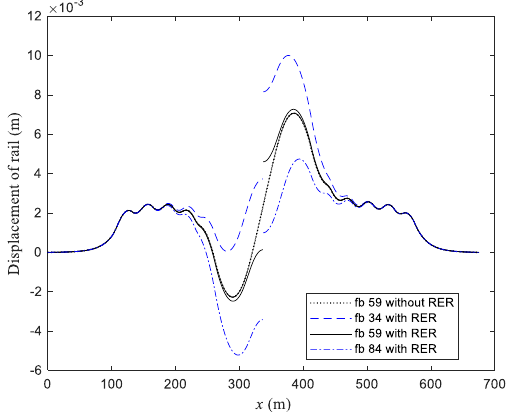
Figure 12. Longitudinal displacement of rail along its length, with the fixed bearing located at three different positions for the length of 150 m of continuous